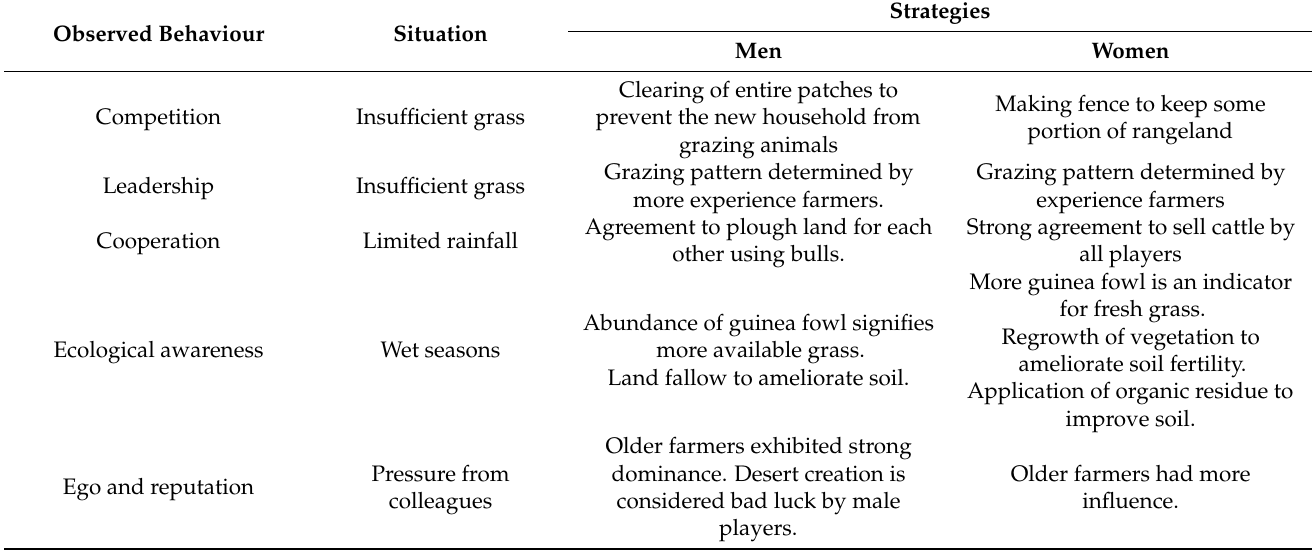
Table 3. Gender-specific observed coping strategies identified under extreme rainfall variability in UER (n female games = 22; n male games = 22).